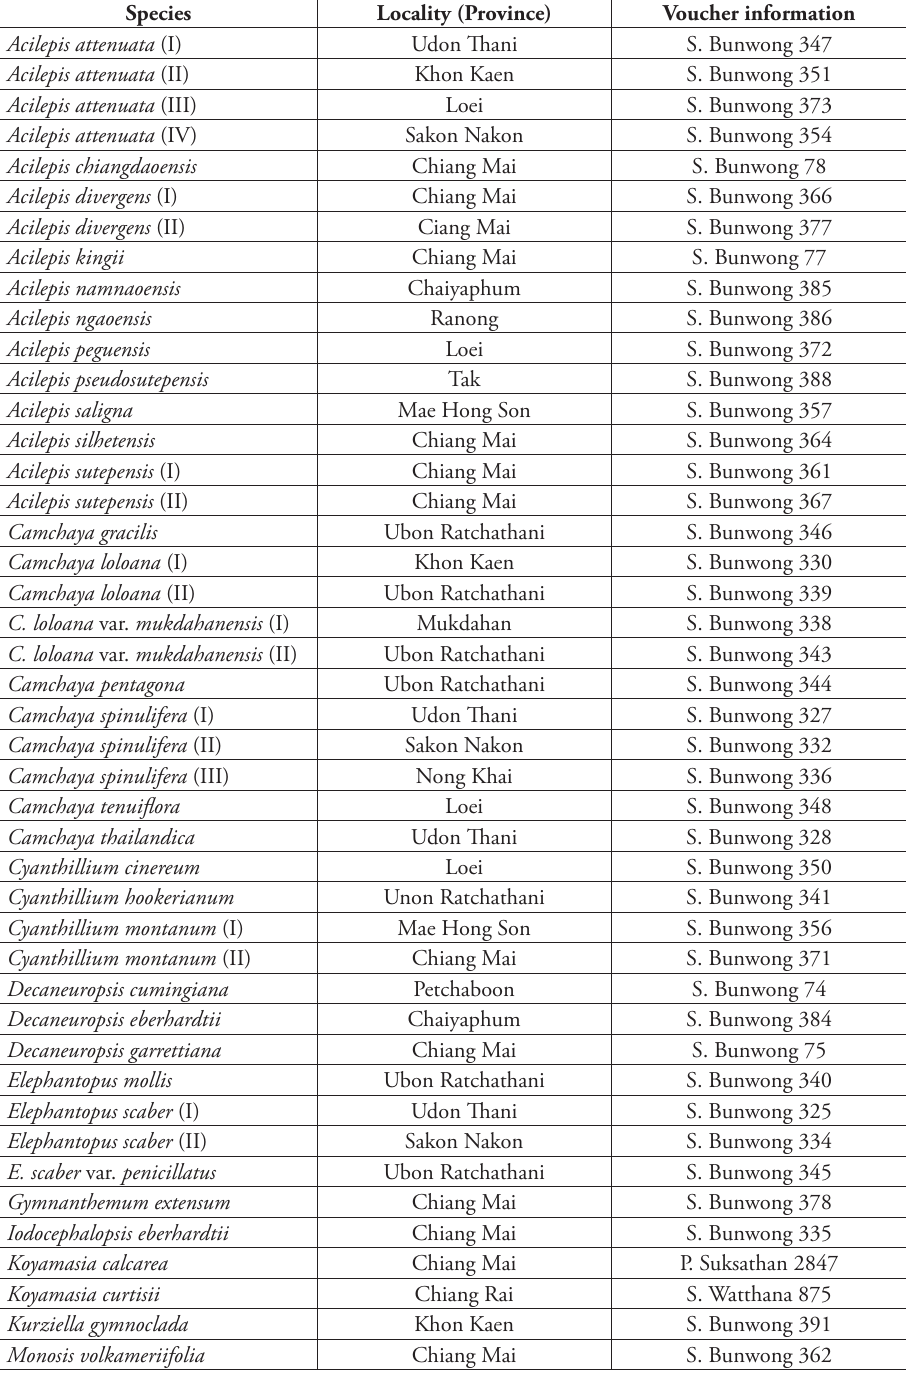
Table 1. Taxa and voucher information for species included in UPGMA